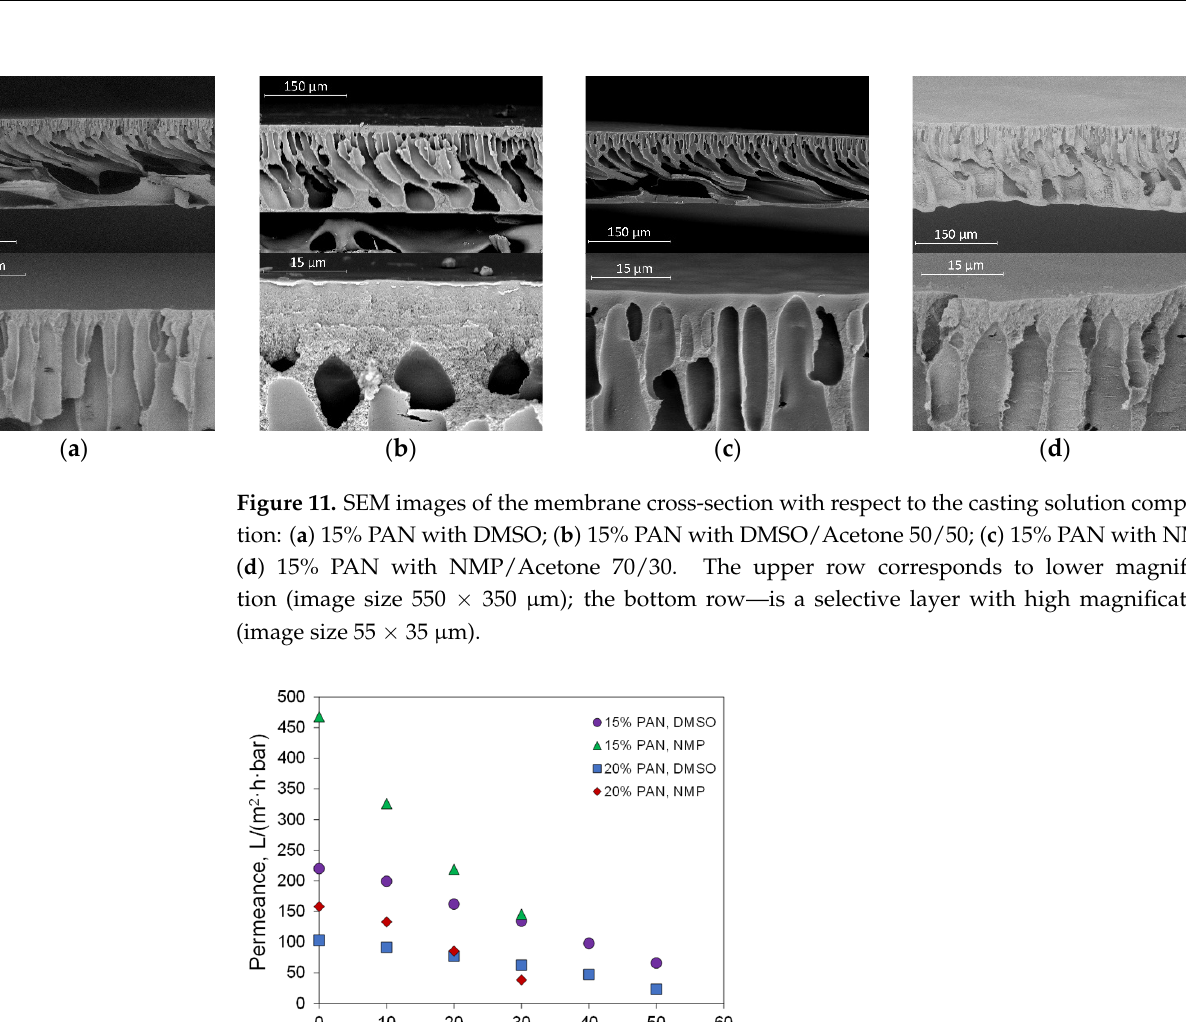
Table 2. Membrane permeance and pore sizes for membranes prepared from different solutions.